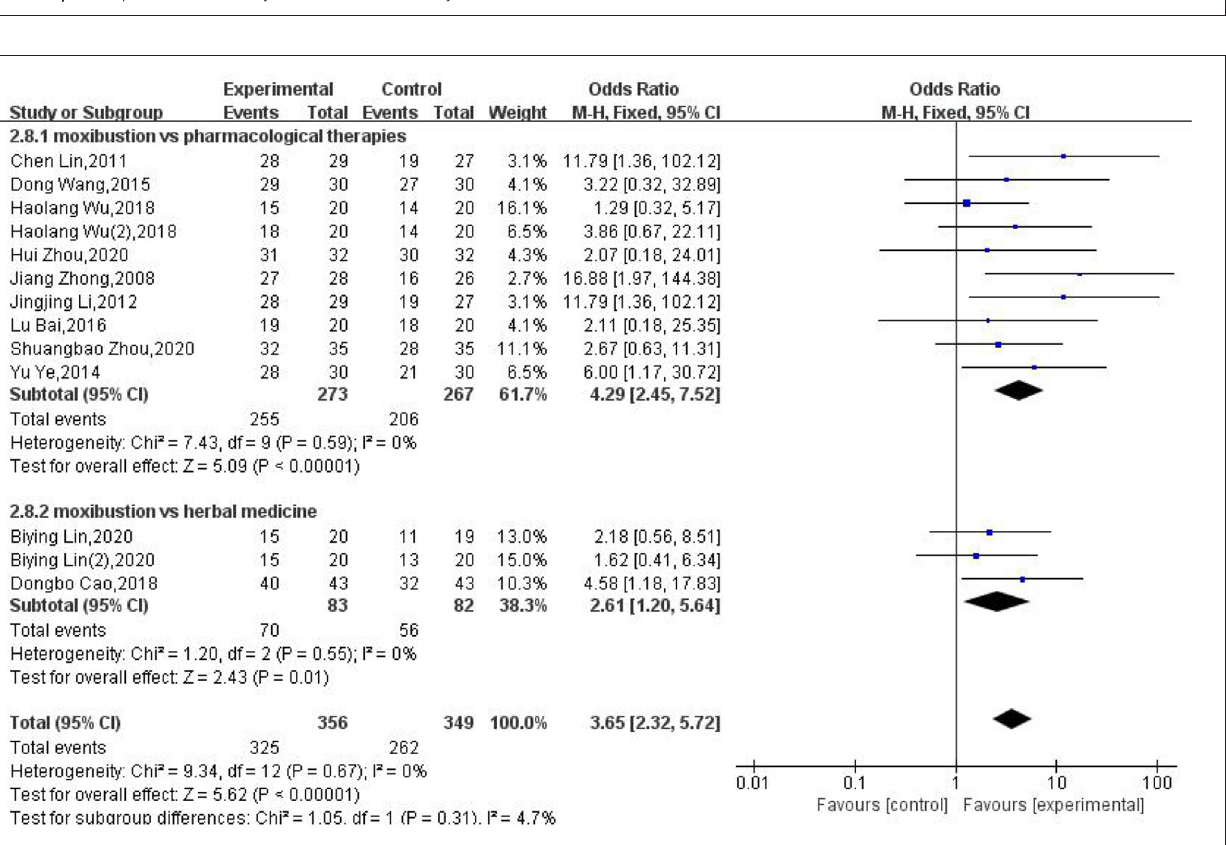
FIGURE 4 | Subgroup analysis of different interventions in the control